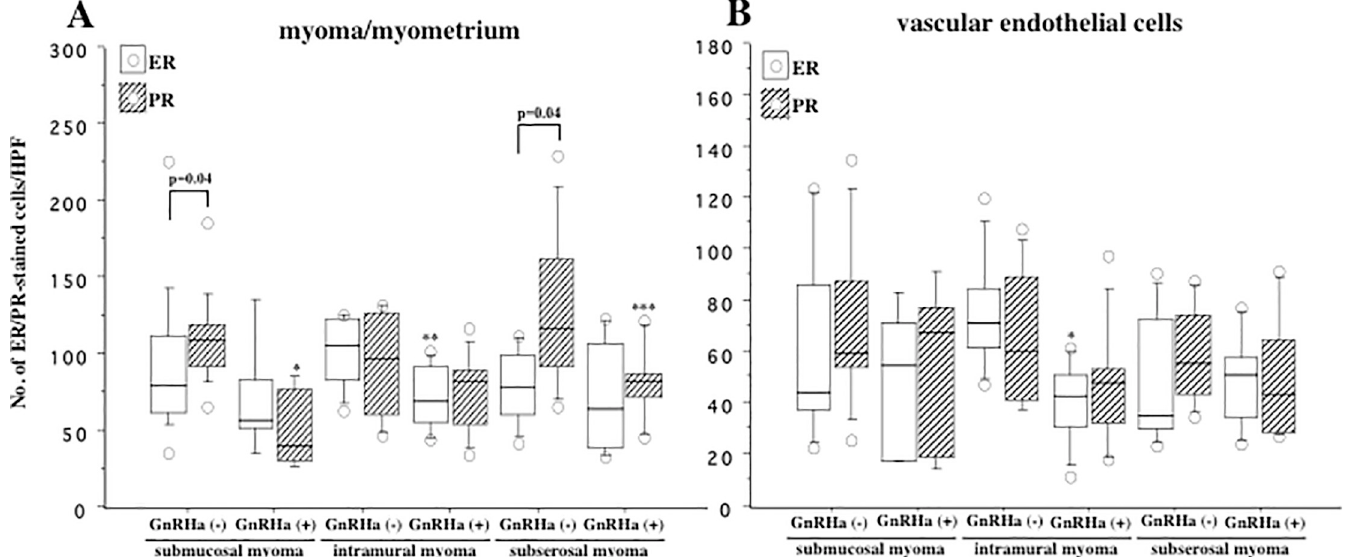
amount of fibrosis between myoma and myometria collected from women with SMM or SSM. The detail percentages of fibrosis in myoma/myometria derived from these three groups of women are shown in S1 Table. Distribution of fibrosis in myoma/myometria derived from GnRHa-treated The distribution of fibrosis as measured by Masson’s trichrome-staining in the myoma and myometria derived from GnRHa-treated and -untreated women with SMM, IMM and SSM is shown in Fig 6A. A variable accumulation of moderate to strong aniline blue-stained collagen fibers (fibrosis) was observed in each biopsy specimens derived from these three groups of women. Computer-captured image analysis in order to quantify the total amount of fibrosis showed no significant difference in the percentage of fibrosis in the combined myoma/myometria between GnRHa-treated and -untreated women with SMM, IMM and SSM (Fig 6B). The detail percentages of fibrosis in combined myoma/myometria derived from GnRHa-treated and -untreated women with different types of fibroids are shown in S2 Table. Perivascular distribution of fibrosis in myoma and myometrium The distribution of Masson’s trichrome-stained collagen fibers (fibrosis) was predominant around the small size and large size vessels in the myoma and myometria derived from women with SMM, IMM and SSM (Fig 7). A variable distribution of dense perivascular fibrosis was found in the myoma and myometria derived from these three groups of